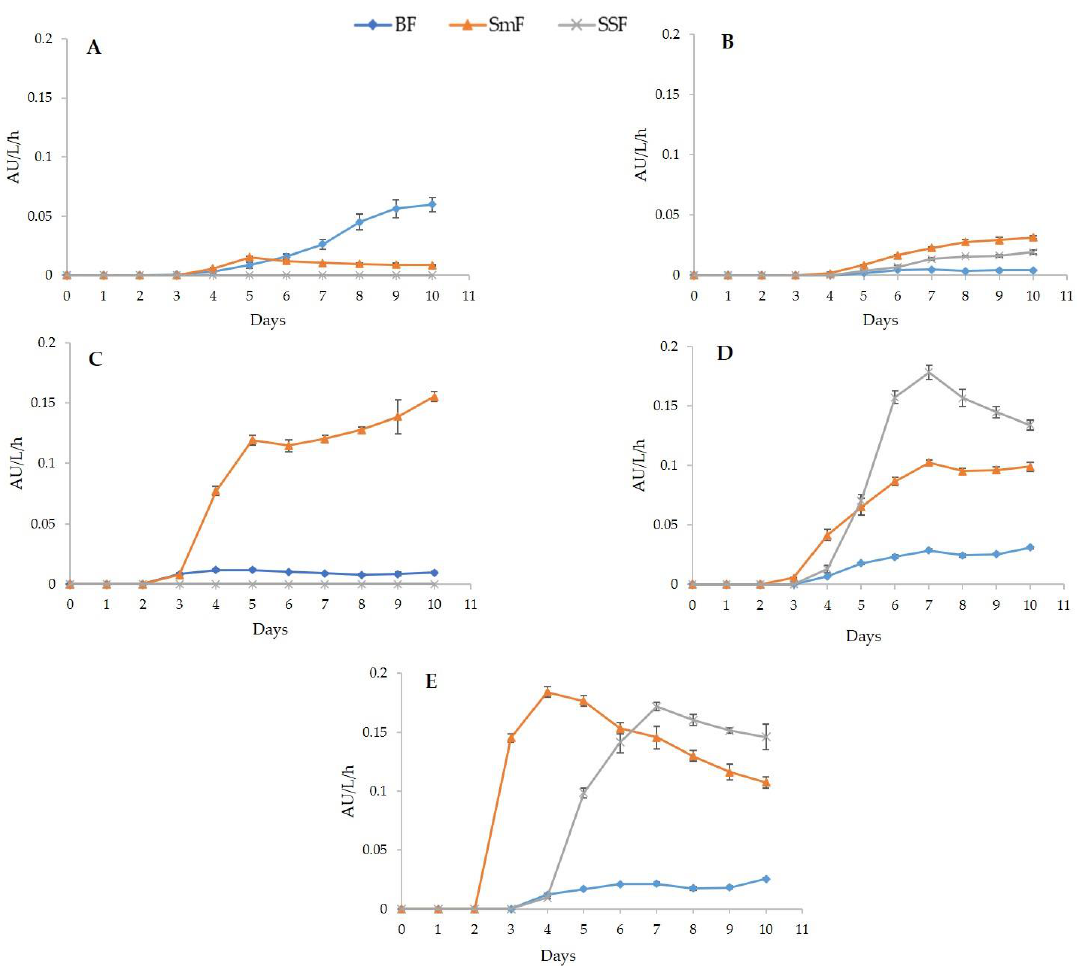
Figure 4. Pigments productivity kinetic curves (AU/L/h) of selected fungal strains cultured in Submerged Fermentation (SmF), Biofilm Fermentation (BF), and Solid State Fermentation (SSF) systems using production medium. ( A ): T. wortmannii LMB-HP14, ( B ): P. mallochii LMB-HP19; ( C ): P. maximae LMB-HP33; ( D ): P. mallochii LMB-HP37; ( E ): T. brunneus LMB-HP43. Data represent the mean of three replicates. Table 2. Pigment production yields (AU/g biomass) of T. wortmannii LMB-HP14, P. mallochii LMB- days in Submerged Fermentation (SmF), Biofilm Fermentation (BF), and Solid State